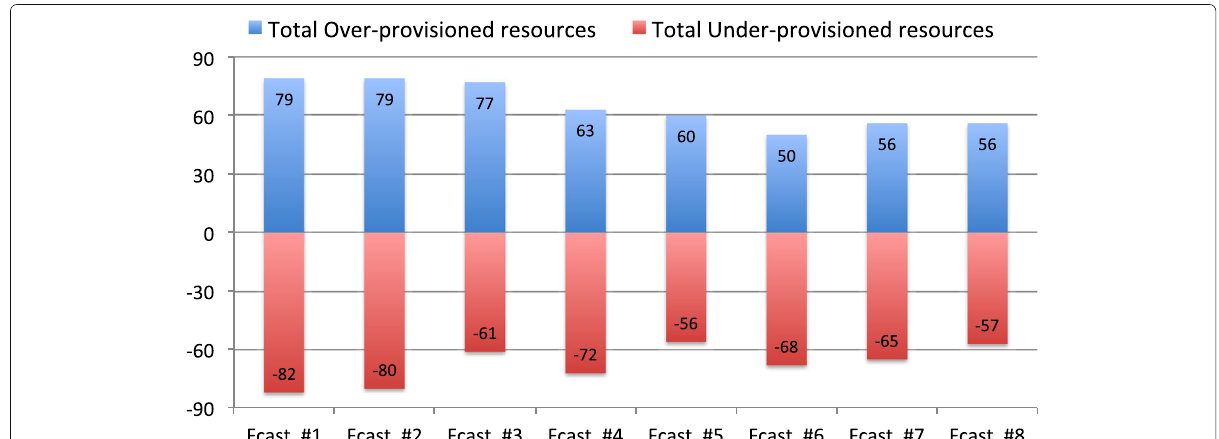
Fig. 7 Over- and under-provisioning of resources using different forecasting models, based on the resource allocation of Table 4 This figure shows the total number of over-provisioned and under-provisioned resources over the 24 h test interval for the different forecasting models (#1 to #8), based on the resource allocation of Table 4. This is computed as the difference between the number of resources that should be provisioned according to the predicted load of the different forecasting models, and the optimal number of resources that should be provisioned according to the real load of the server for the 24 h test interval